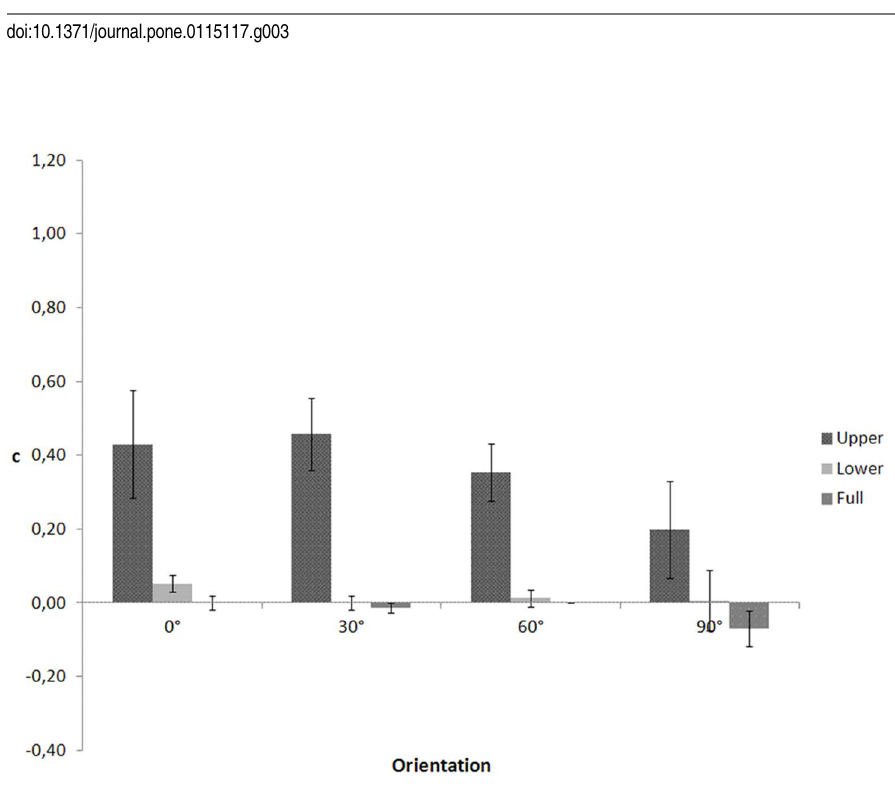
Fig. 3. d’ as a function of visible body part and figure orientation for the walking action in Experiment 2.